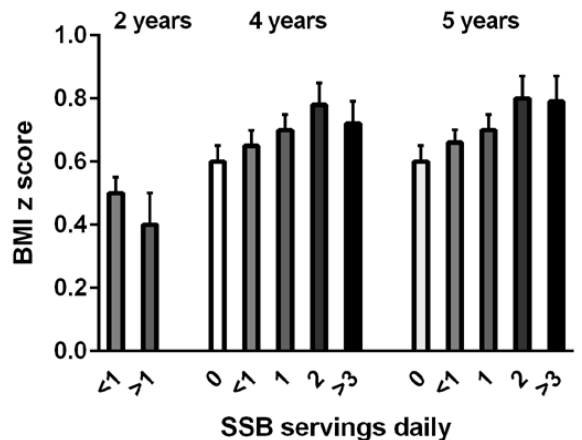
Figure 3. Mean BMI z scores of children aged 2, 4, and 5 years showing daily consumption of sugar sweetened beverages (SSBs), which was significantly different versus nondrinkers of SSBs (from de Boer et al. , 2013 [85], with permission).